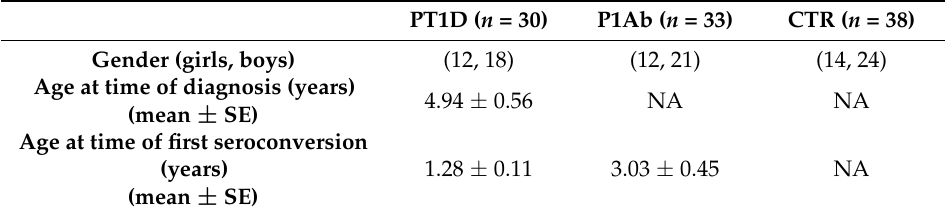
Table 1. Anthropometric characteristics of the study